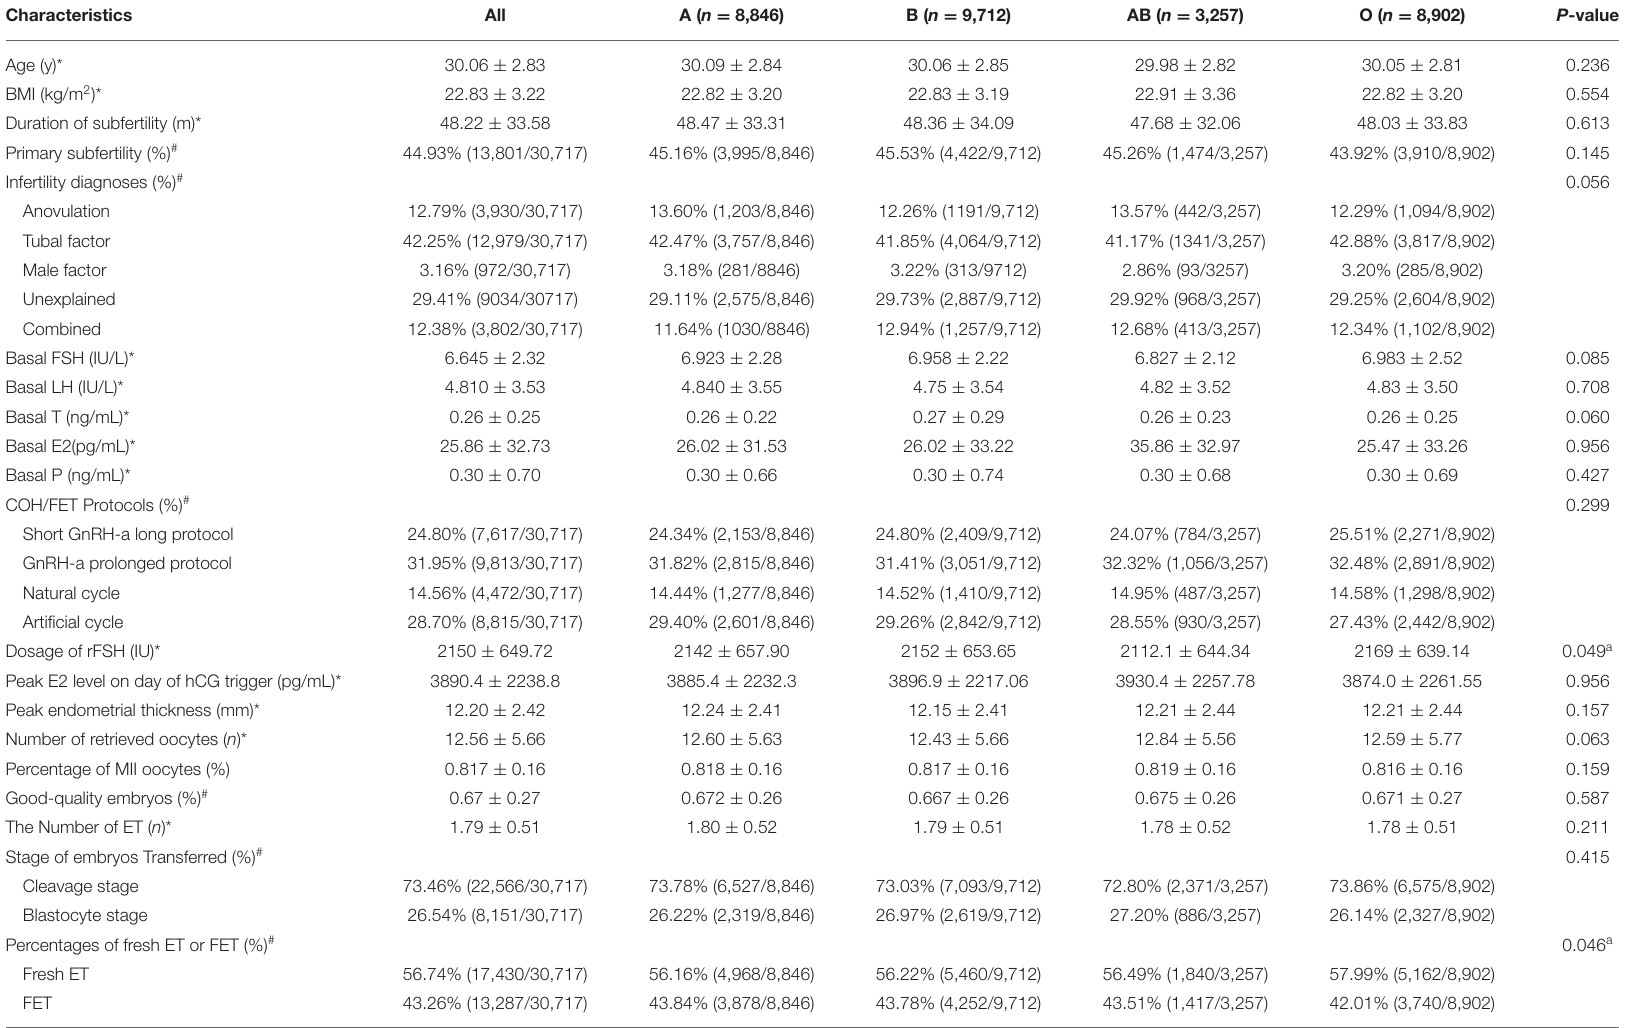
* Indicates continuous variables, presented as mean ± standard deviation (SD). # Indicates categorical variables, presented as percentage (number). a Indicates P < 0.05, but no significant difference between each group. BMI, body mass index; FSH, follicle-stimulating hormone; LH, luteinizing hormone; T, testosterone; E2, estradiol; P, progesterone; COH, controlled ovarian hyperstimulation; FET, frozen-thawed embryo transfer; rFSH, recombinant follicle stimulating hormone; ET, embryo